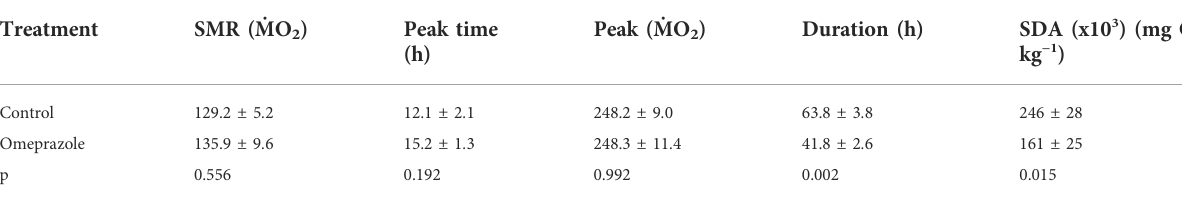
TABLE2Standardmetabolicrate(SMR)andSpeci fi cDynamicAction(SDA)parametersmeasuredinNiletilapia( Oreochromisniloticus )voluntarilyfed a meal of 2% BM of either sham-treated pellets (Control) or pellets treated with omeprazole at a fi nal dose of 25 mg kg − 1 BM. The variables were compared using paired t-tests n = 8.